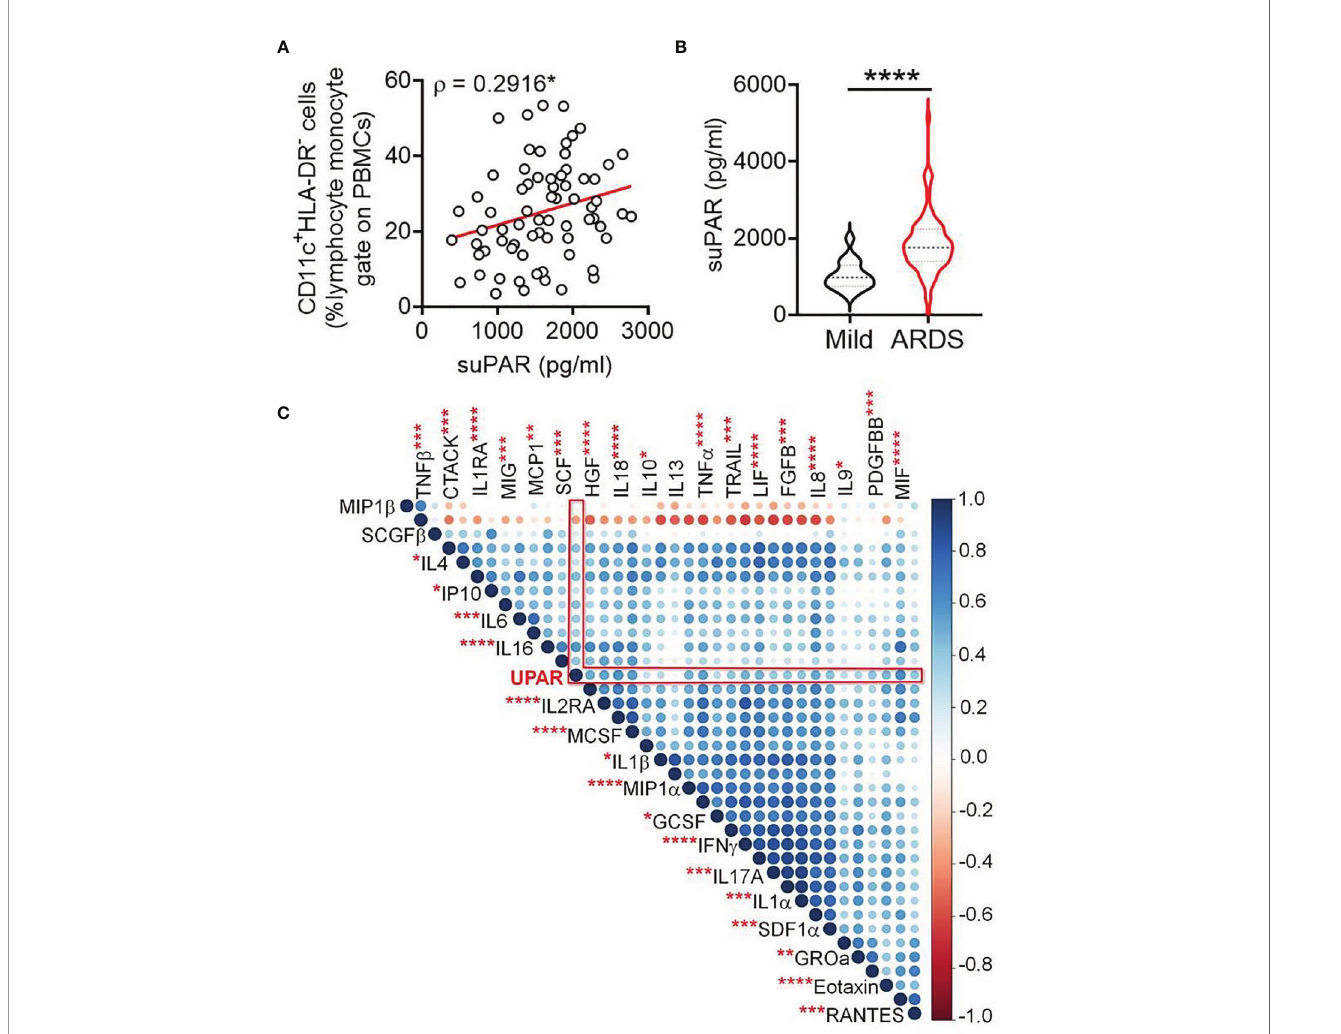
FIGURE 3 | Increased plasma abundance of soluble uPAR and its cellular source in severe COVID-19. (A) Correlation between frequency of circulating CD11c + HLA-DR – myeloid cells and plasma levels of suPAR in COVID-19 patients. (B) Plasma level of suPAR compared between COVID-19 patients with either mild disease or ARDS. (C) Corr plot showing mutual correlation between the plasma levels of 36 cytokines and soluble uPAR in COVID-19 patients with ARDS. The dots are color-coded and size-scaled for the Spearman r values for individual correlations; signi fi cance levels for correlation between plasma levels of suPAR and individual cytokines are noted as superscripts on cytokine names, ****p < 0.0001, ***p < 0.0005, **p < 0.005, and *p <